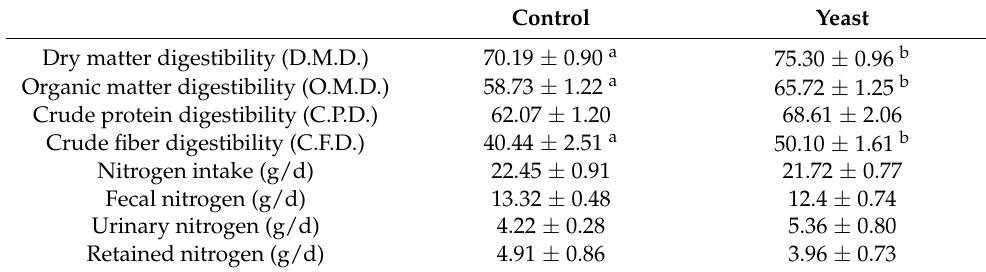
Urinary nitrogen (g/d) Retained nitrogen